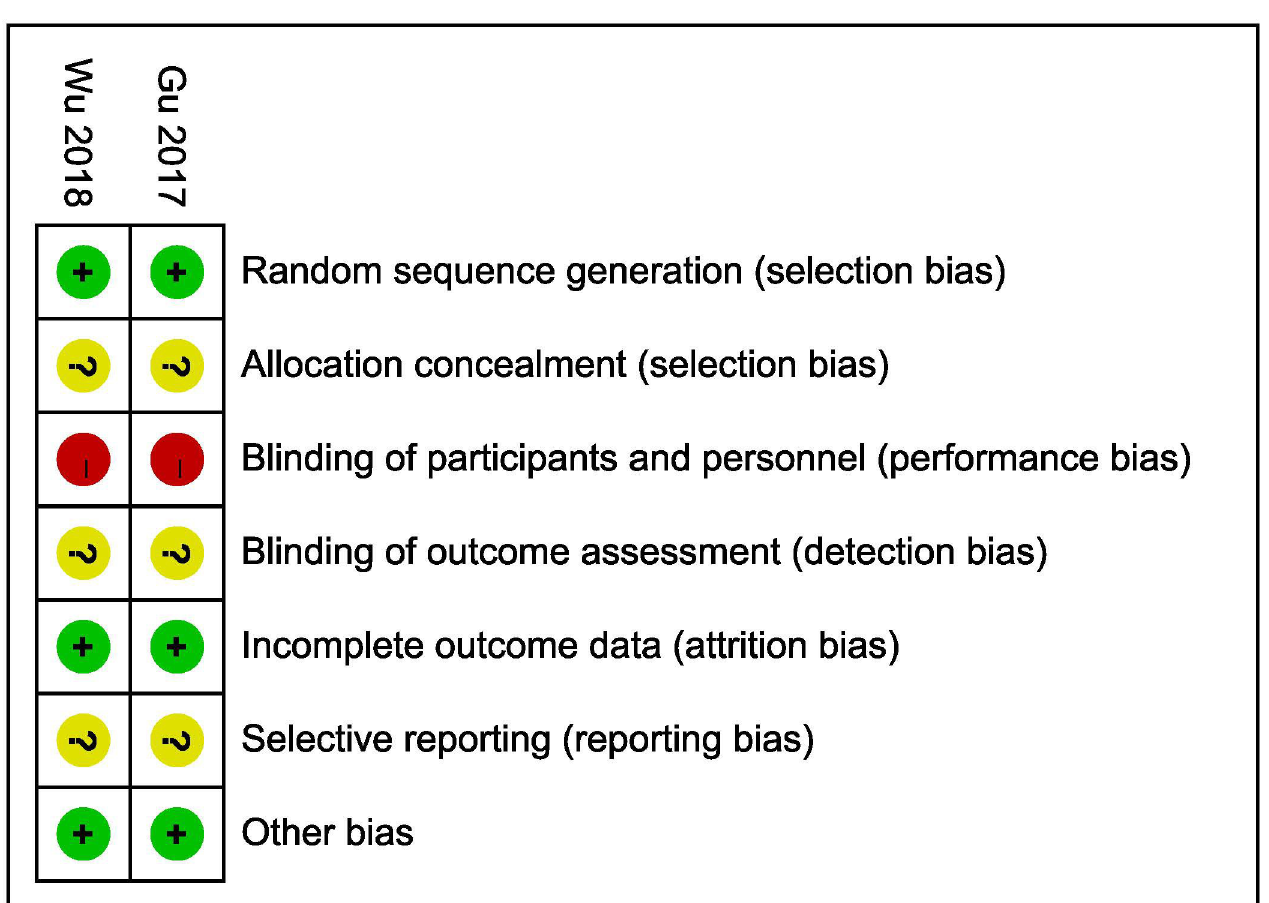
Fig 2. The methodological quality for